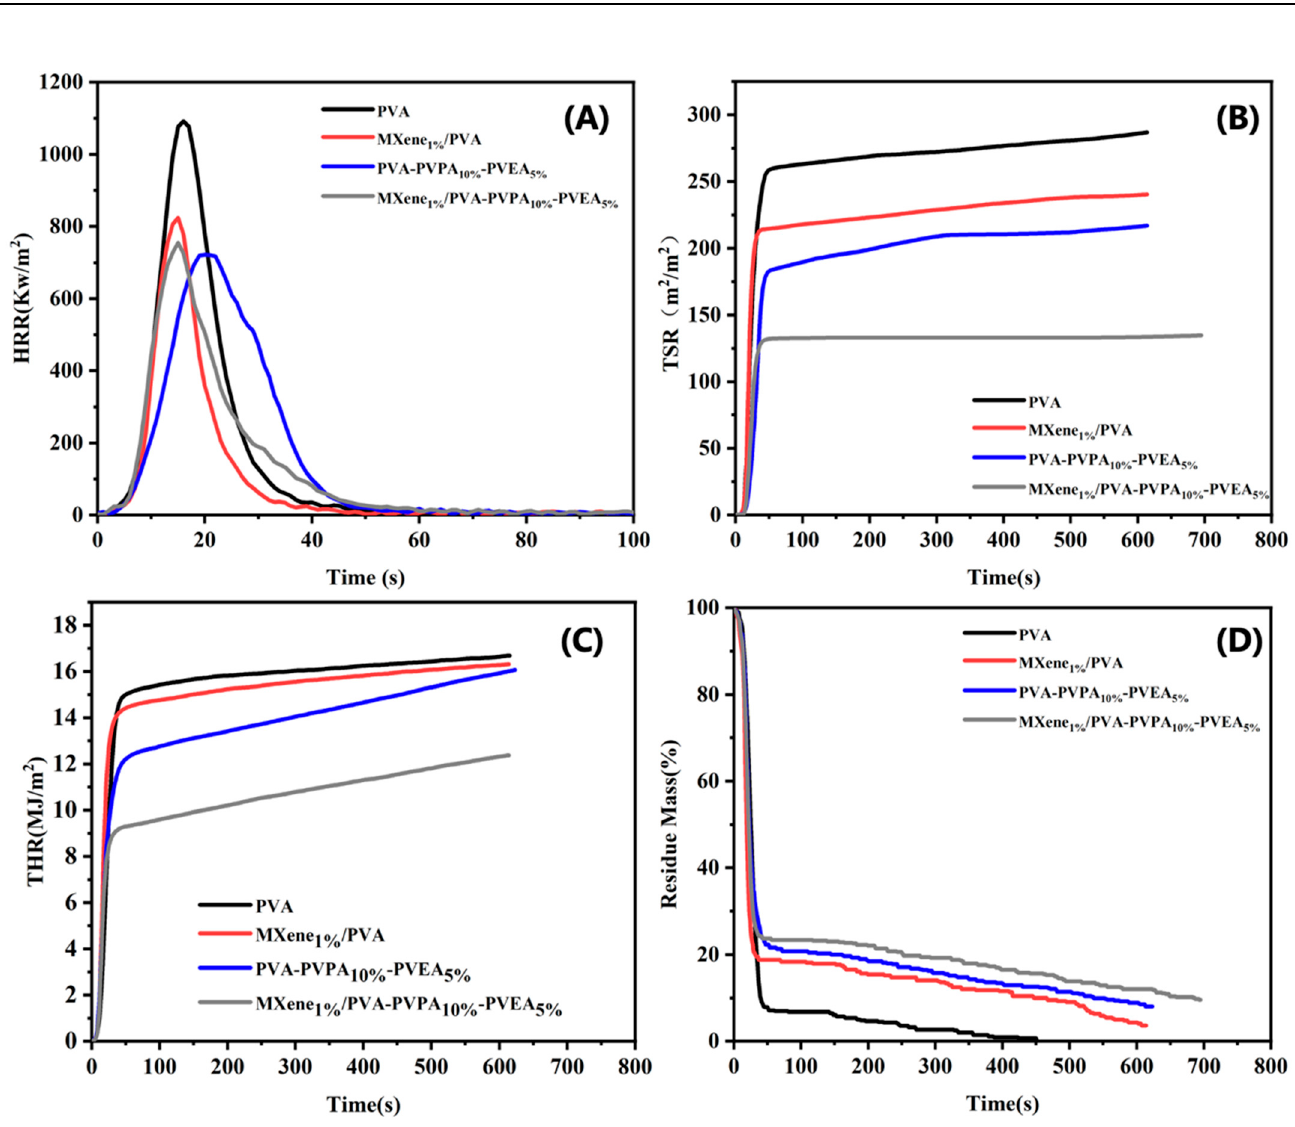
Figure 5. HRR ( A ), THR ( B ), TSR ( C ), Residue ( D ) curves of PVA and MXene/PVA nanocomposites.